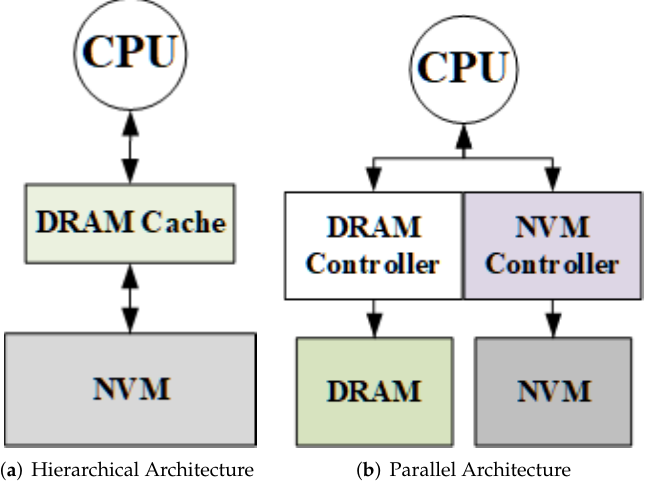
Figure 1. Hierarchical and parallel hybrid memory